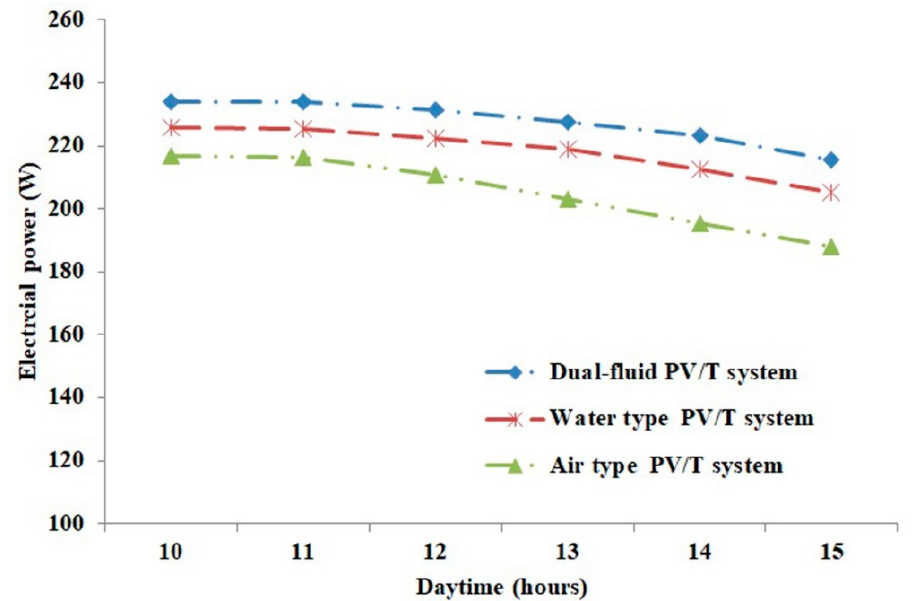
Figure 7. Daily electrical power of PV/T systems plotted against different fluid operations.